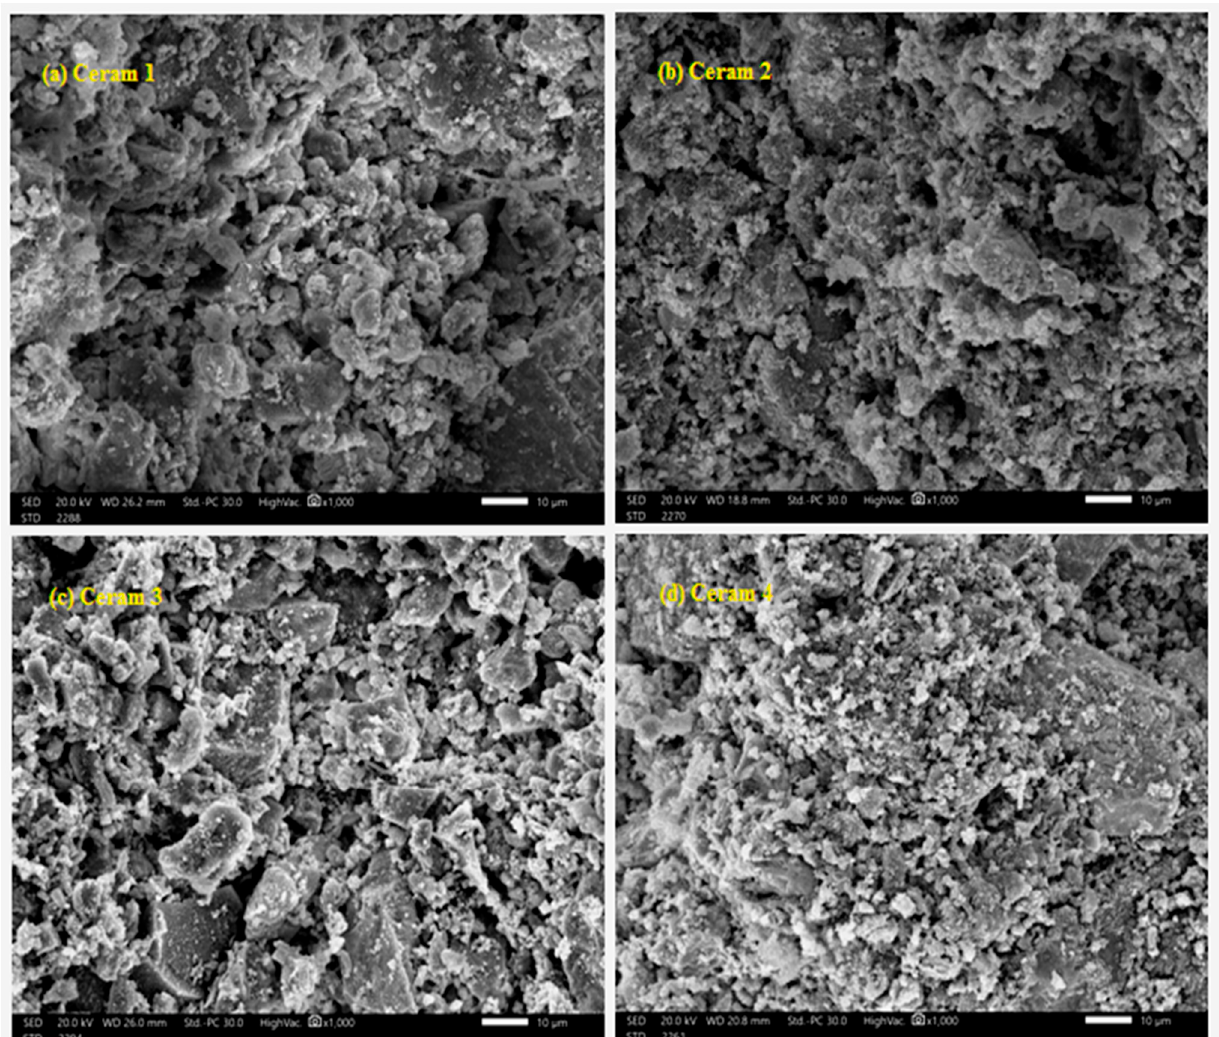
Figure 3. SEM images of Ceramic samples, ( a ) Ceram 1, ( b ) Ceram 2, ( c ) Ceram 3 and ( d ) Ceram 4.